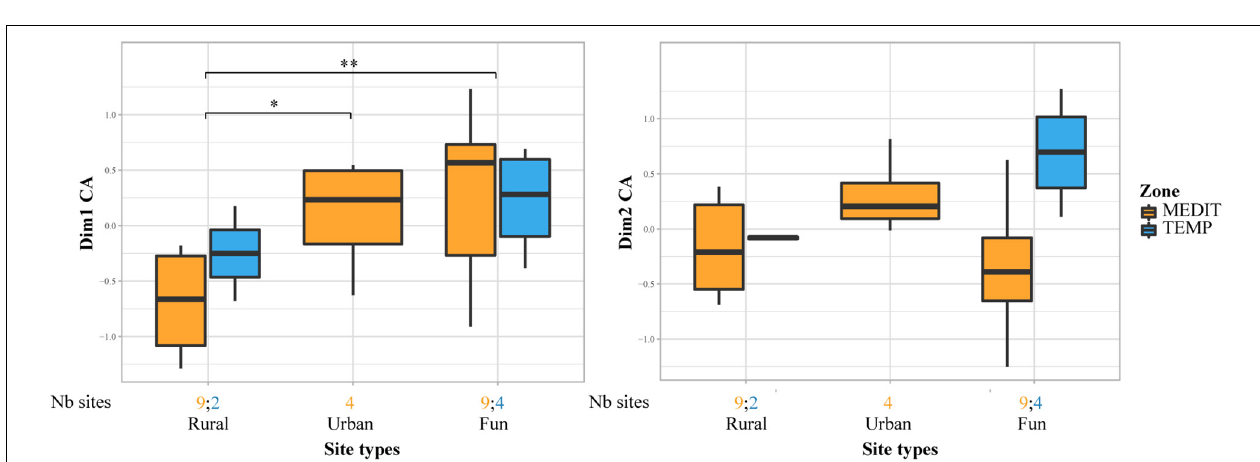
FIGURE 7 | Comparison of site types for the Early Roman period. Only Rural, Urban and Funerary/ceremonial sites are taken into consideration. Box plots showing the distribution of sites on axis 1 and 2 of the CFA performed on charred fruit remains in Roman sites, in relation to site types and bioclimatic zones. Statistical significances of the Wilcoxon tests are indicated on the box plots, only when the result is significant ( ∗ p ≤ 0.05; ∗∗ p ≤ 0.01). The number of sites for each site category and bioclimatic zone is provided at the bottom of the